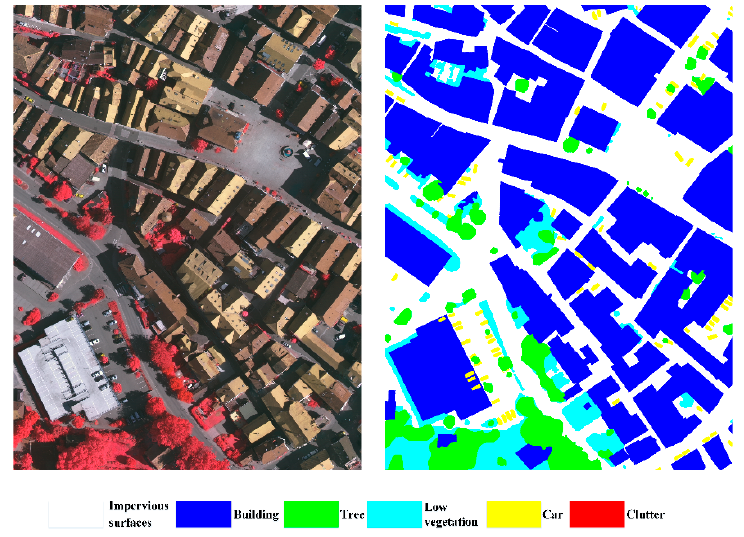
Figure 5. A Sample of the ISPRS Vaihingen Benchmark.